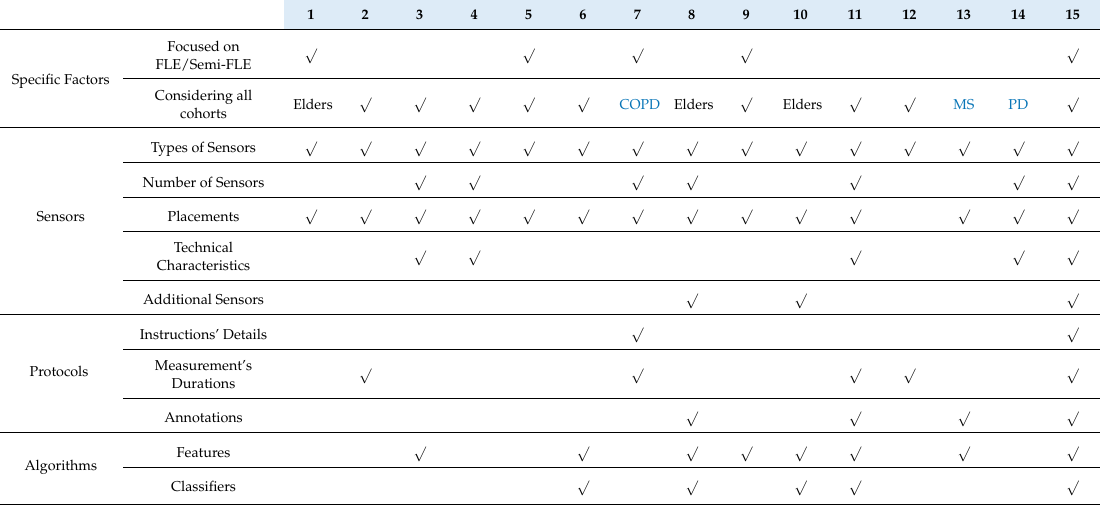
Table 1. Comparison of our review to other existing reviews dealing with the use of wearable motion sensors in free-living settings. 1 → De Bruin et al. [46] (2008), 2 → Murphy [49] (2009), 3 → Yang and Hsu [52] (2010), 4 → Schwickert et al. [55] (2013), 5 → Gorman et al. [45] (2014), 6 → Attal et